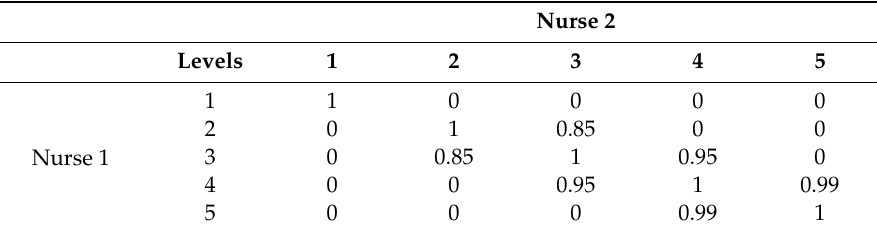
Table 1. Discrepancy weighting system for the estimation of Cohen’s kappa inter-rater agreement adapted for the bilateral k c2 index used to assess the reliability of the Emergency Severity Index (ESI) triage system in the Emergency Service Department of the General Hospital of La Palma. Nurse